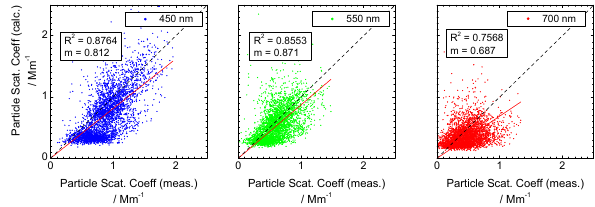
(bottom panel, black dots). To highlight the annual cycle also in the particle number concentration, the plots contain the respective running 4-week 5th percentiles (grey line), which are again based on hourly values.